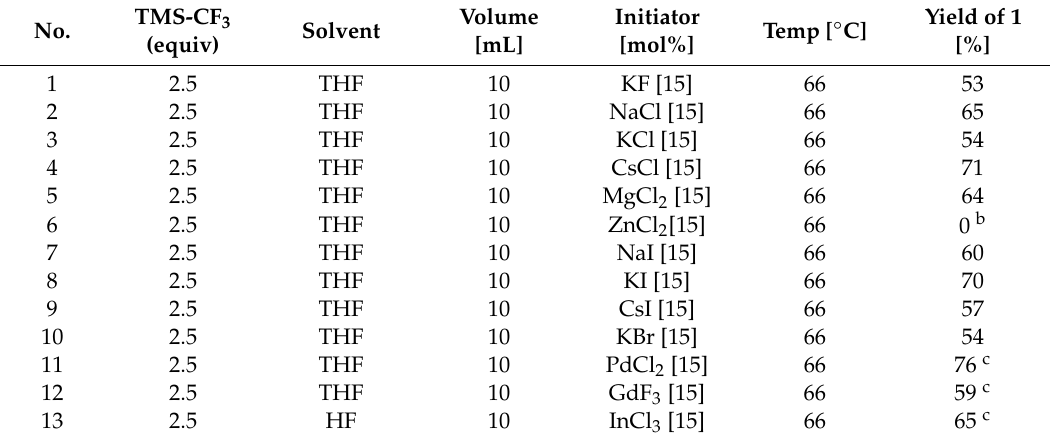
Table 4. Optimization of the reaction conditions using various metal halides as initiators and TMS-CF 3 as the carbene source a .